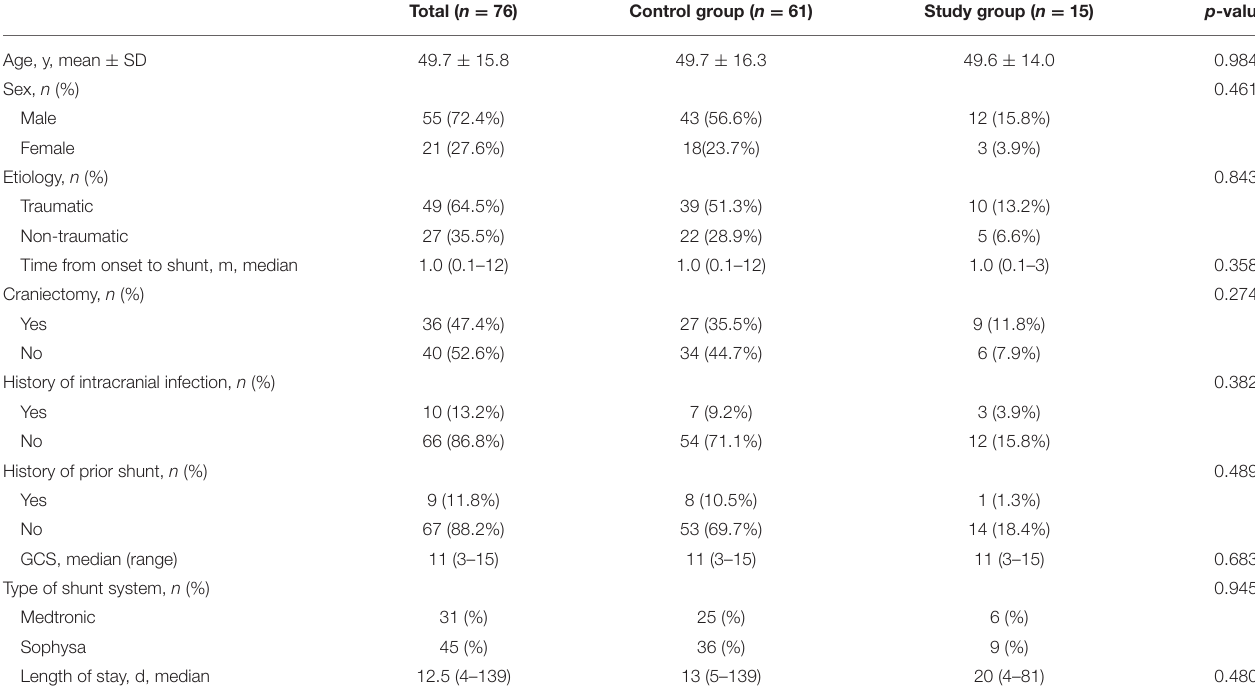
TABLE 1 | Baseline